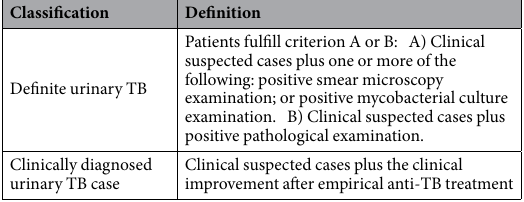
Table 1. Diagnostic criteria of urinary